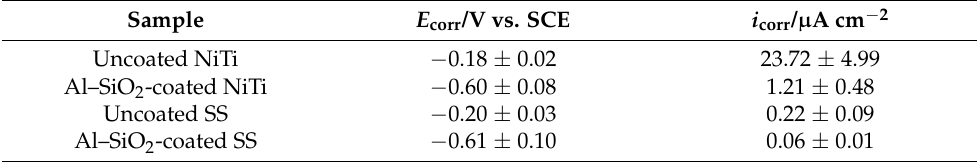
Figure 5. Electrochemical results for the coated archwires. Dynamic polarization curve of the NiTi group ( a ). Dynamic polarization curve of the SS group ( b ). Table 2. Corrosion parameters from the polarization curves. Table 2. Corrosion parameters from the polarization curves.